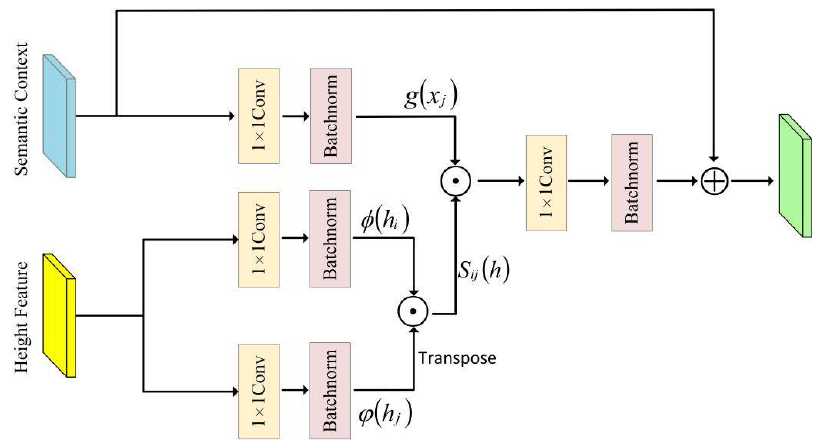
Figure 5. Illustration of our height feature guide propagation.